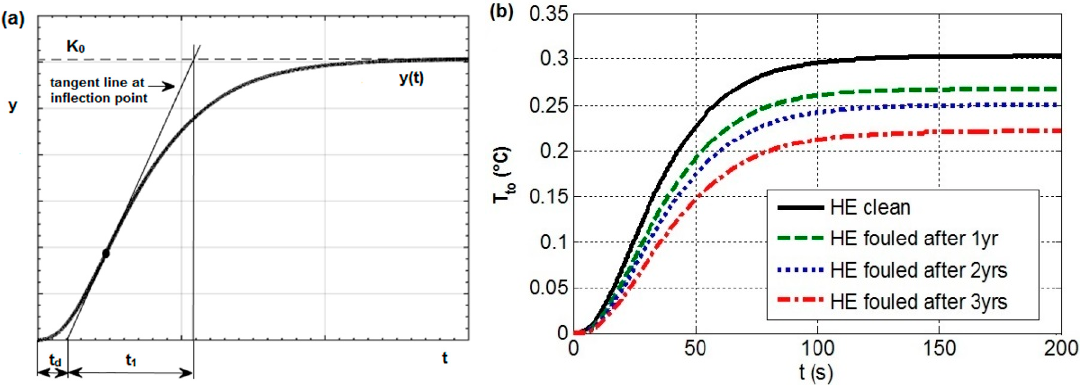
Figure 6. A typical open-loop unit step response of a thermal system ( a ) and the step responses of a HE under fouling conditions ( b ).